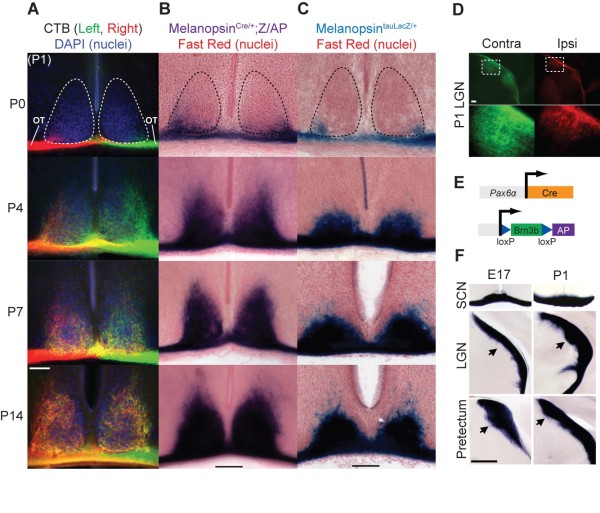
ipRGCs innervate the suprachiasmatic nucleus postnatally. Innervation of the suprachiasmatic nucleus (SCN) begins at P0 and continues throughout the first two postnatal weeks. (A) Labeling of all RGCs in coronal sections with fluorescently labeled cholera toxin B subunit (CTB), one color per eye. Retinal fibers fill the SCN by P7 and innervation becomes bilateral by P14. Note that for CTB labeling, a P0 time point was not possible due to the survival period required for the tracer to label distal axons. (B,C) Labeling of ipRGCs and their axons with both MelanopsinCre/+;Z/AP (B) and MelanopsintauLacZ/+ (C) reveals a similar innervation pattern. (D-F) In contrast, CTB labeling reveals RGC axons have already penetrated the LGN by P1 (D), and genetic labeling of Brn3b-positive RGCs (E) reveals that this subset of RGCs begins entering the pretectum as early as E17 (F). Arrows indicate fibers entering target area. n = 3 or more animals for each time point. OT, optic tract; dashed outlines demarcate the SCN prior to innervation in (A,B). Scale bars: 100 μm (A-C); 500 μm (F).